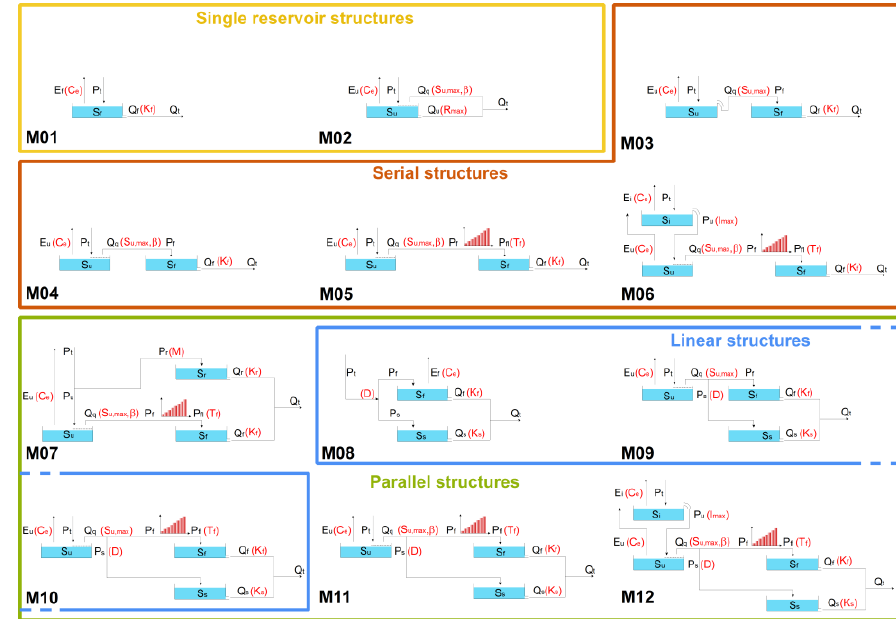
Figure 2. Model structures, adapted from Fenicia et al. [17]. D: partition between fast and slow reservoir; E f (Ce): actual evaporation; E u (Ce): unsaturated evaporation; I = interception; K: storage coefficient; P: precipitation; Q: discharge; S: storage; Su max : storage; β: power function; f = fast; r = riparian; s = slow; t = total; u = unsaturated. Table 1. Parameter ranges of the 12 model structures. All parameters, except D and M, are converted to a logarithmic value for calibration.